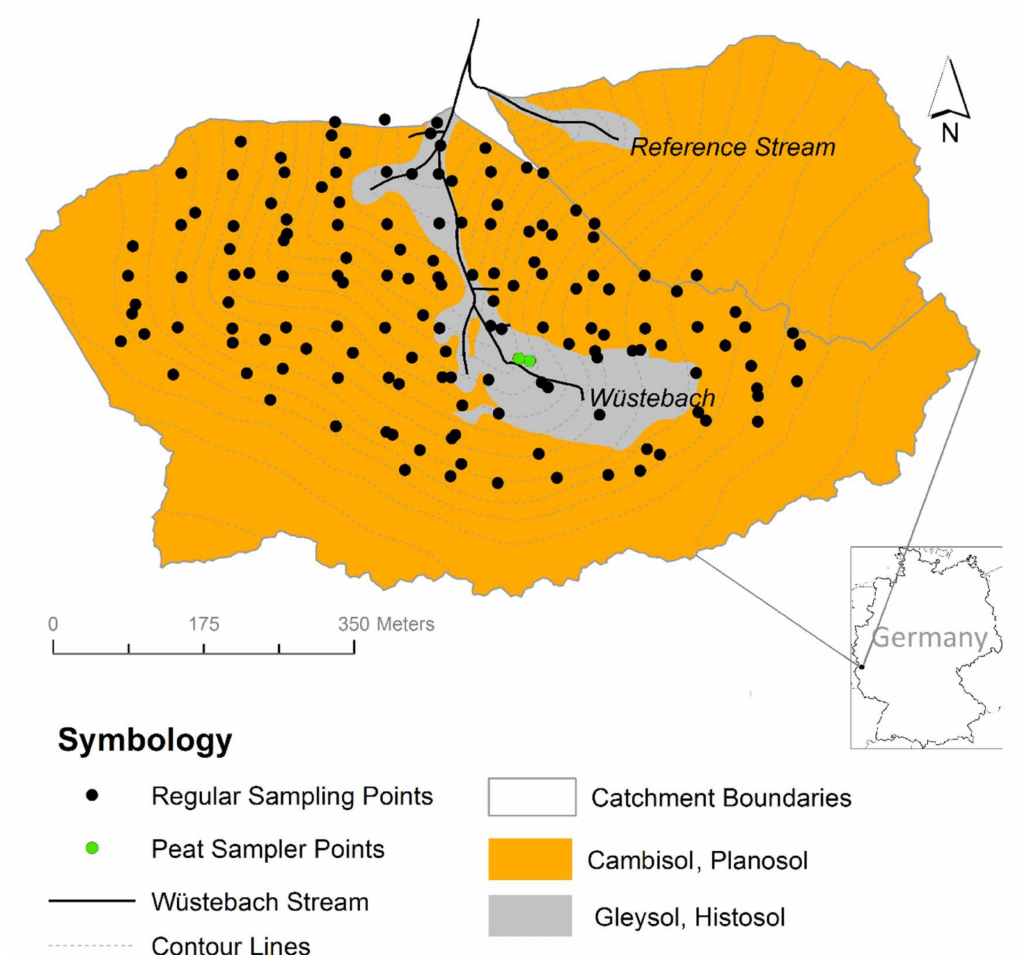
Figure 1. Distribution of soil sampling locations in the Wüstebach catchment. Adjusted from Gottselig et al. [28]. Resolution of the soil map: